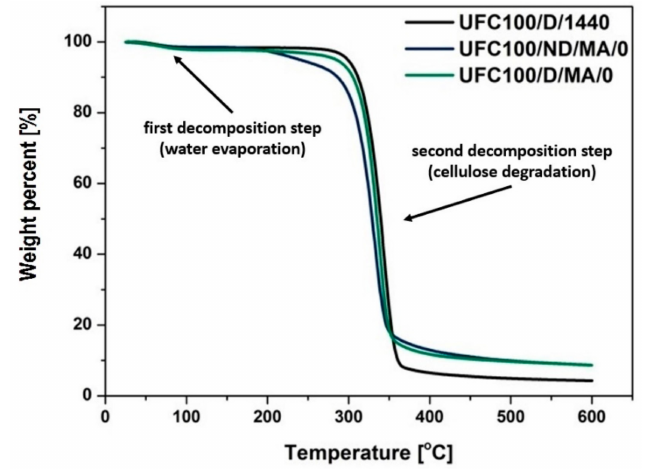
Figure 8. Comparison of MA treatment e ff ect on thermal properties of dried and not dried cellulose